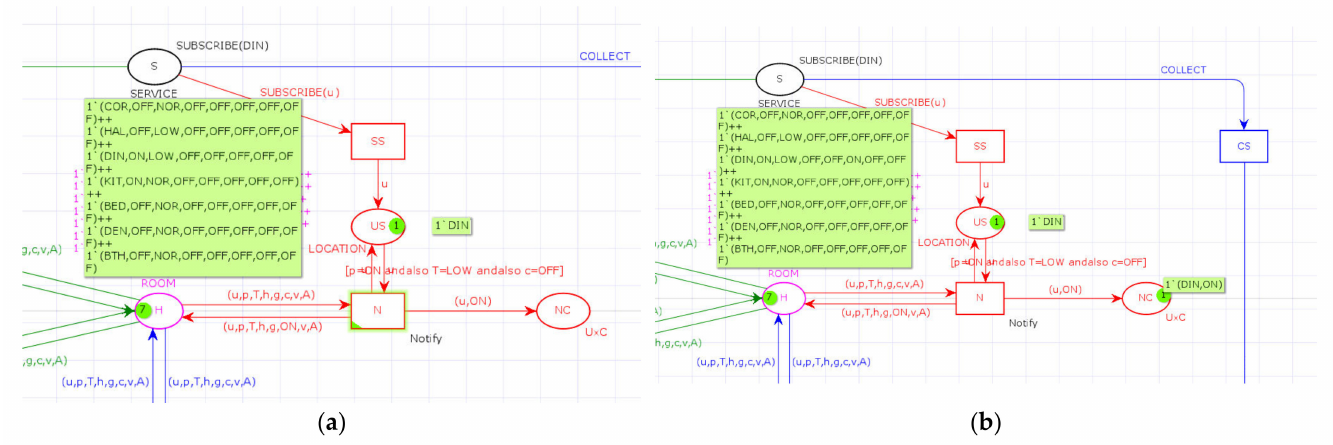
Figure 3. Subscription for notification service behavior. In ( a ), transition N is enabled by the marking, showing only one subscriber in place US. In ( b ), a notification for the subscriber has been deposited in place